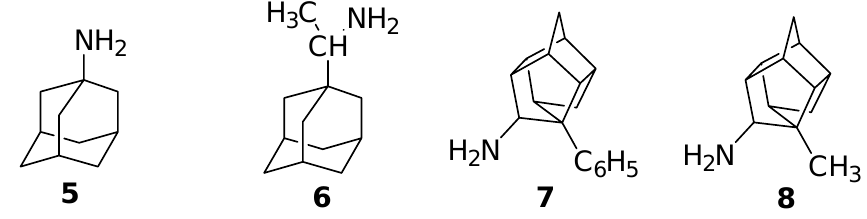
Figure 1: Examples of bioactive cage-like polycyclic